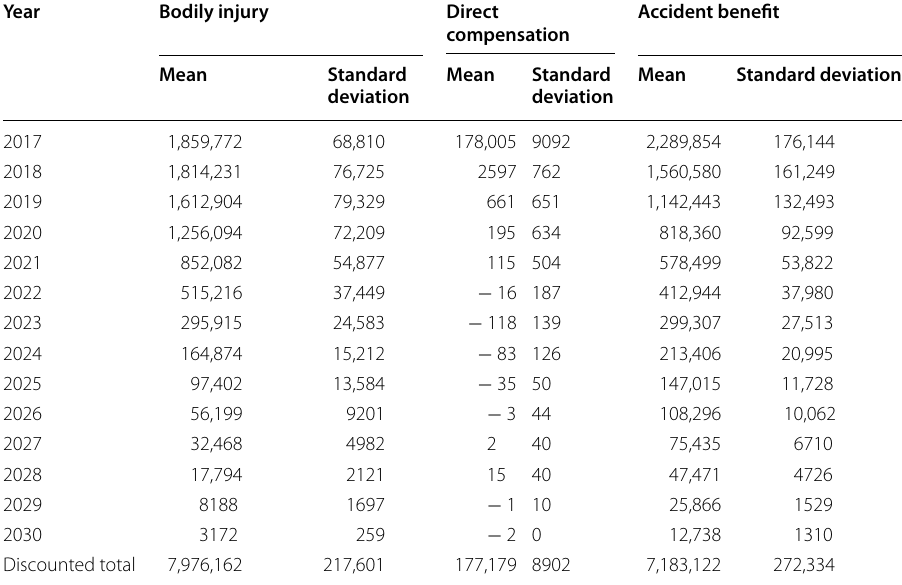
All amounts are in thousands in Canadian dollars